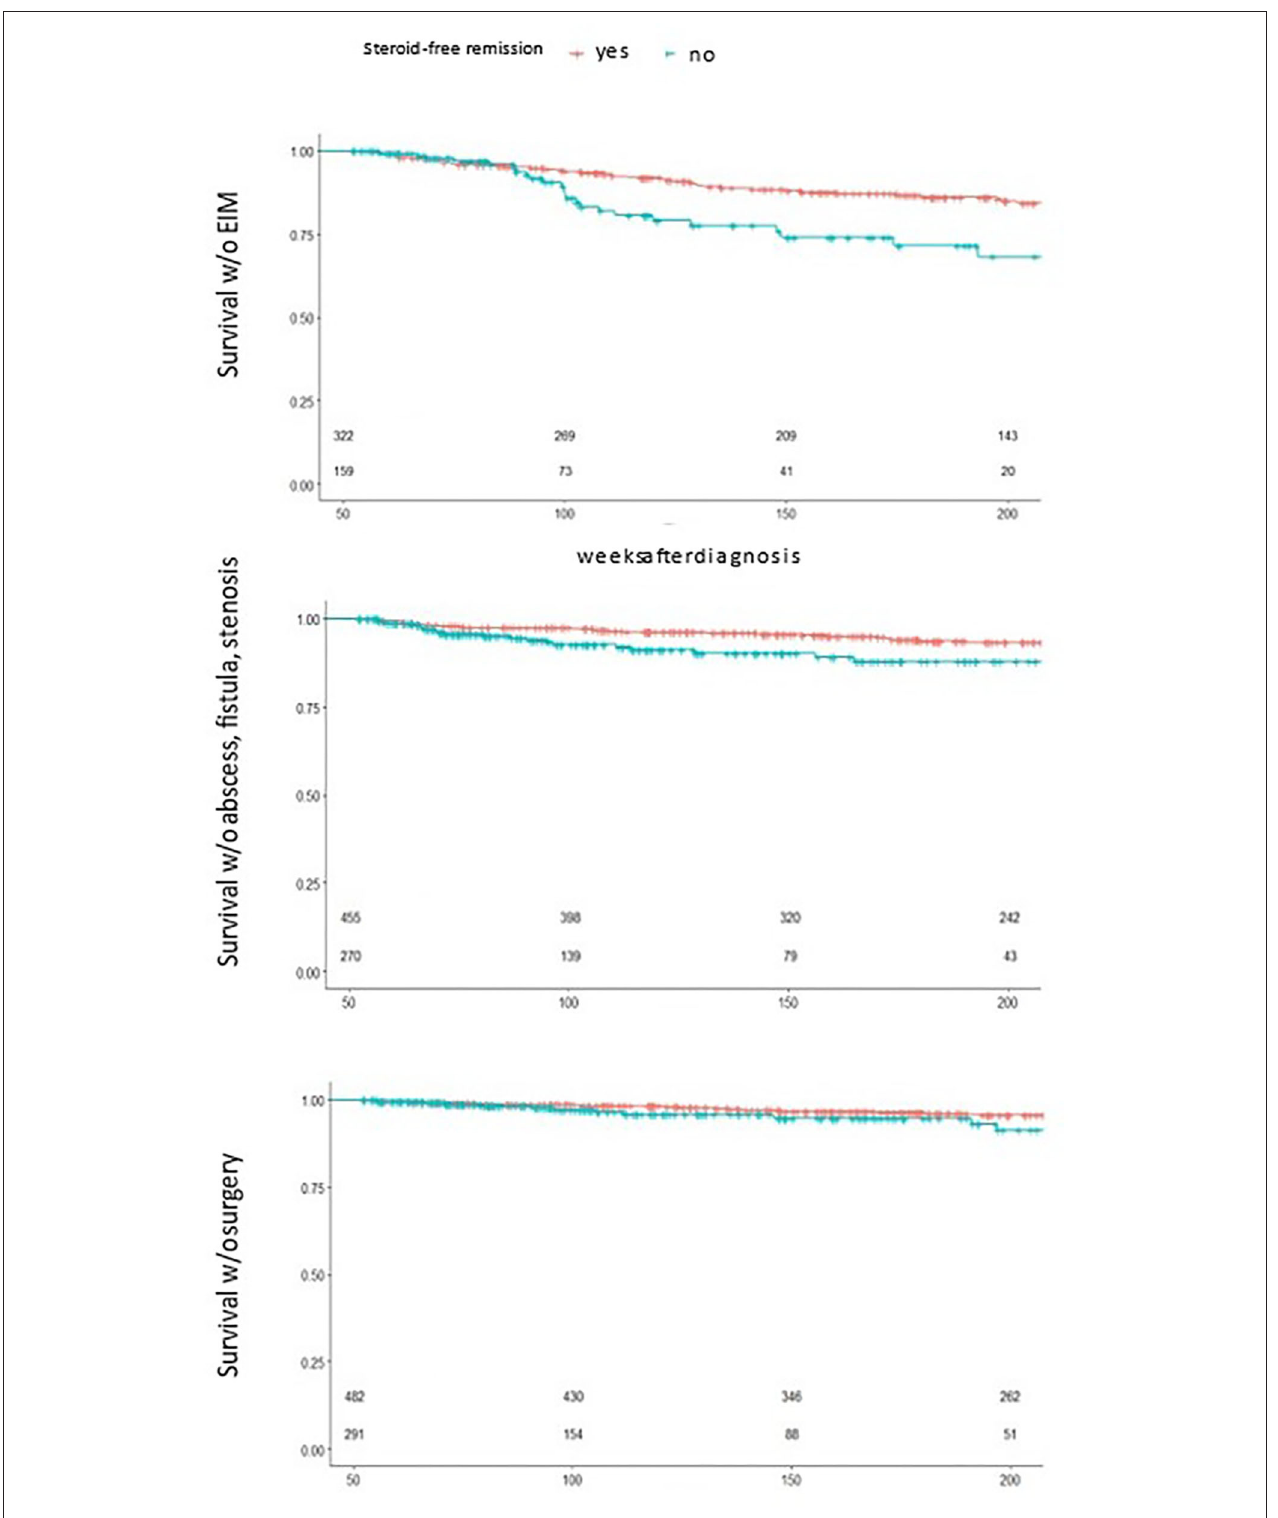
FIGURE 4 | Survival analysis by 1 year steroid free remission. Statistically significant reduced event free survival for children who did not reach 1 year steroid free survival toward EIM(top), abscess, fistula and stenosis (middle) and surgery (bottom), small numbers n patients under risk.